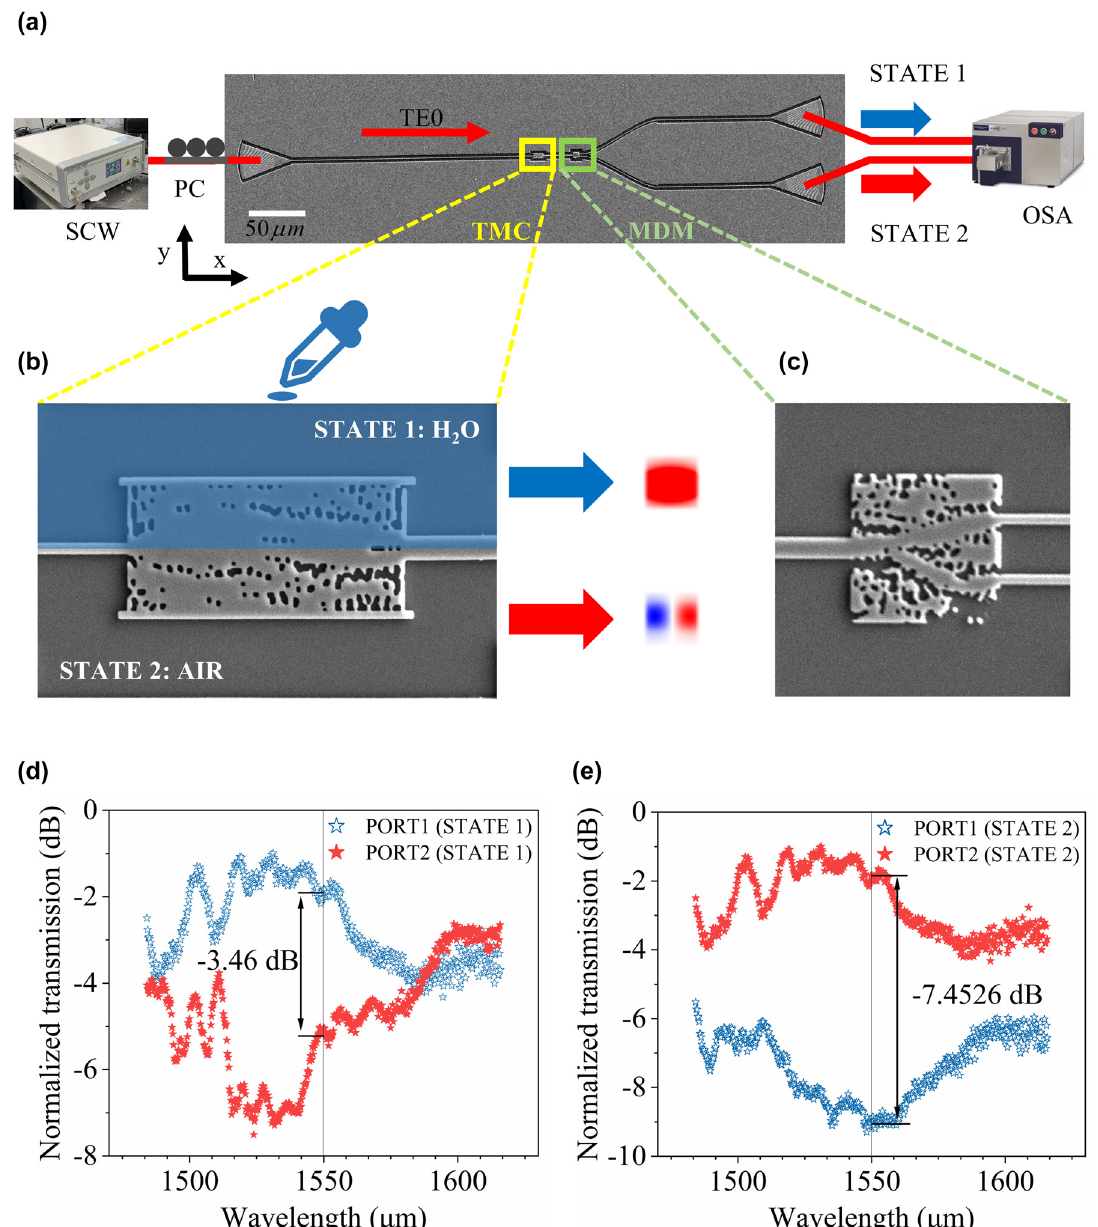
Figure 5: The experimental setup and the scanning electron microscopy image of our system. (a) Experimental setup for device characterization (SCW, supercontinuum wave laser; PC, polarization controller; TMC, tunable mode converter; MDM, mode demultiplexer; OSA, optical spectrum analyzer). The top-down view of the device is taken by scanning electron microscope. The yellow box indicates the tunable mode converter, and the green box indicates the mode demultiplexer. (b) The top-down view of the mode converter can implement tunable mode conversion by dropping a small amount of water on this device. (c) SEM image of the mode demultiplexer. (d) and (e) The experimental results for the whole system. Measured transmission spectra of the two output ports, validating the functionality of these